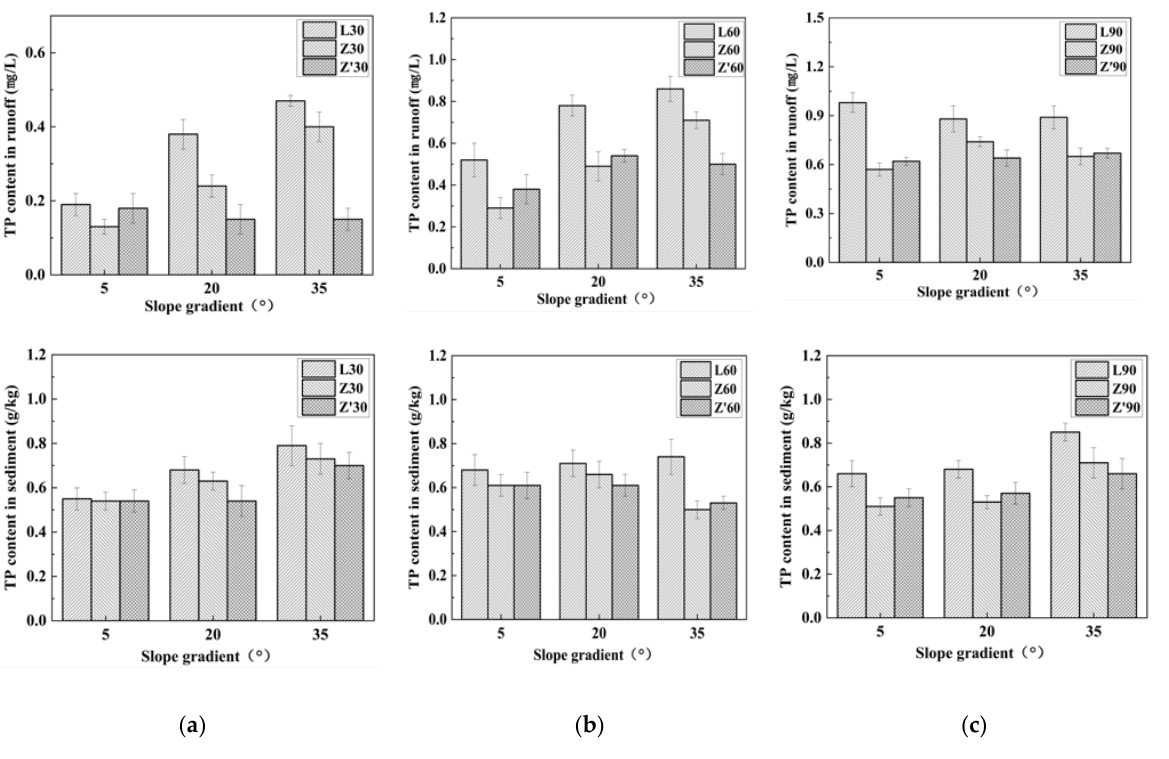
Figure 6. Effect of rainfall intensity, slope gradient on TP loss in runoff and sediment under different vegetation coverage types: ( a ) Rain intensity is 30 mm/h; ( b ) Rain intensity is 60 mm/h; ( c ) Rain intensity is 90 mm/h.